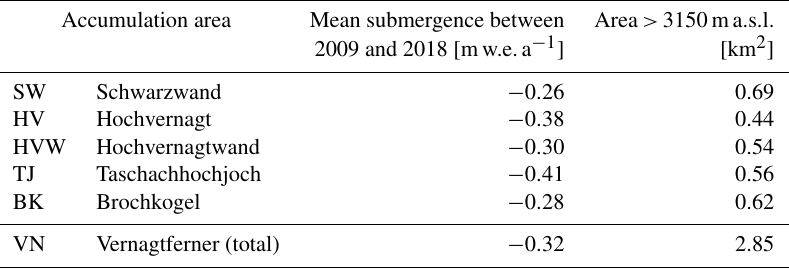
Figure 10. Variation raster 2009–2018: spatial variations of the annual geodetic (corrected) and glaciological mass balance data; blue areas with negative variations represent areas where B geod ,t < B glac , t . In red areas, the opposite relation is present (see Eq. 7). For regions that appear yellow, both methods present similar mass balances; black outlines represent the different accumulation areas of the Vernagtferner. Table 3. Mean values of the variation raster 2009–2018 (Fig. 10) for the accumulation areas in mw.e.a − 1 , interpreted as submergence; the associated error is ± 0 . 25mw.ea − 1 for all submergence